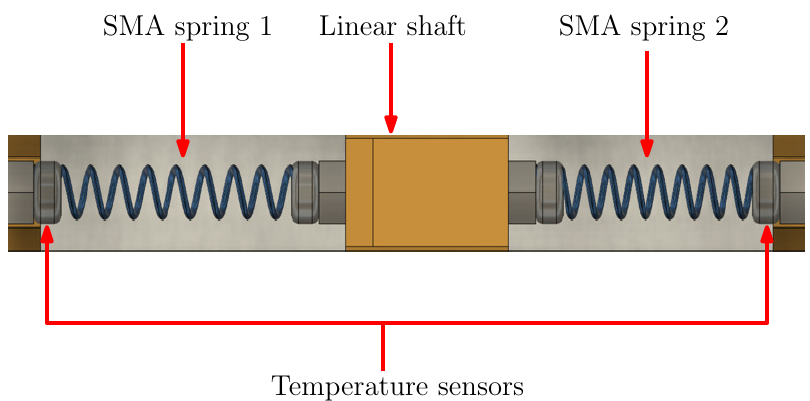
Figure 7. Upper view of the SMA linear actuator design.